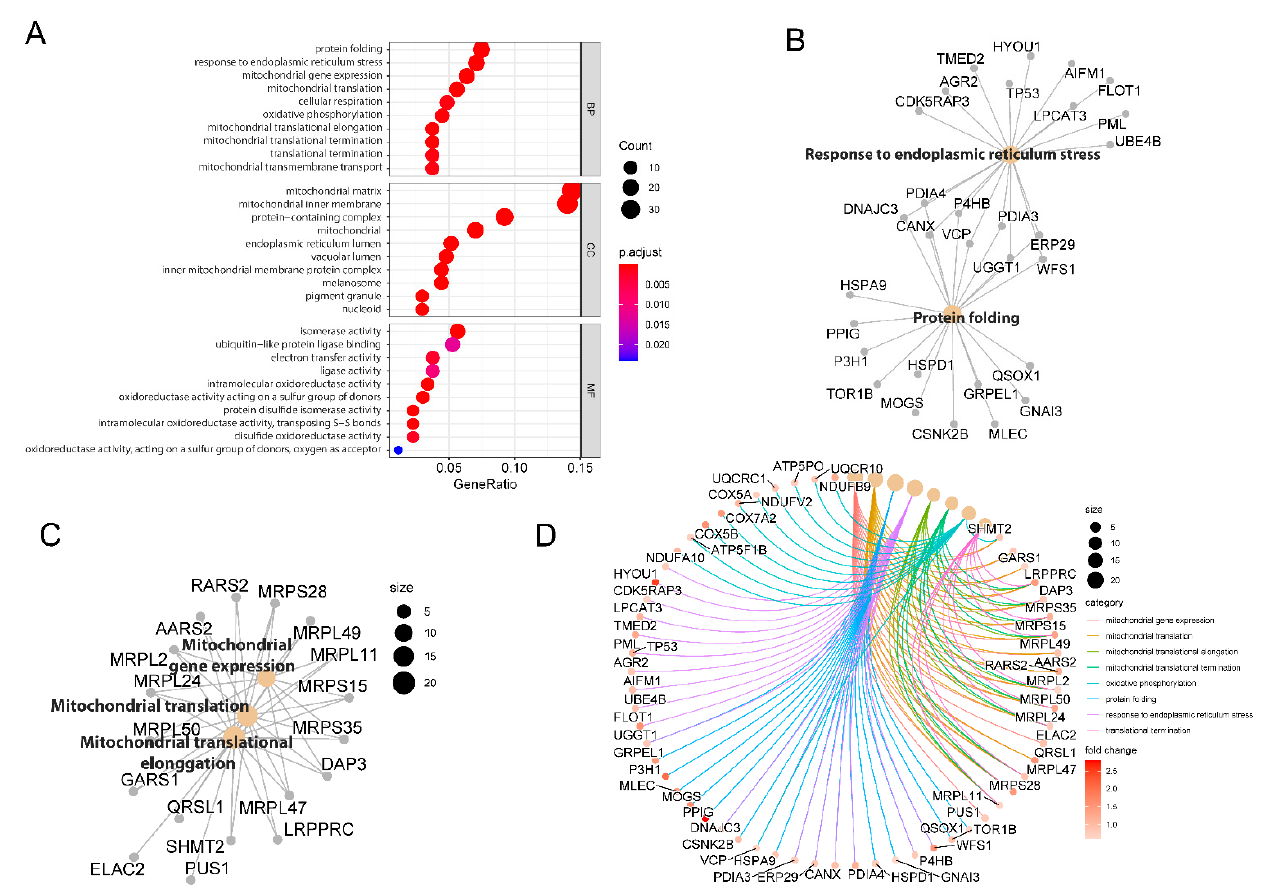
Figure 2. Functional clustering annotation of proteome changes induced by 2DG. ( A ) GO analysis of up-regulated proteins associated with 2DG treatment in the HT29 cell line. Cnetplot plots show the most significant enriched terms with associated proteins. The dotplot diagram was performed in RStudio 4.0 using the ggplot2 R package. ( B ) The cnetplot diagram shows the relationship between the protein sets associated with the biological processes of response to endoplasmic reticulum stress and protein folding. ( C ) The cnetplot diagram shows the relationship among the protein sets associated with biological process of mitochondrial gene expression, mitochondrial translation, and mitochondrial translational elongation. ( D ) The cnetplot-circular diagram shows the 68 up-regulated proteins associated with the eight top-ranked biological processes.